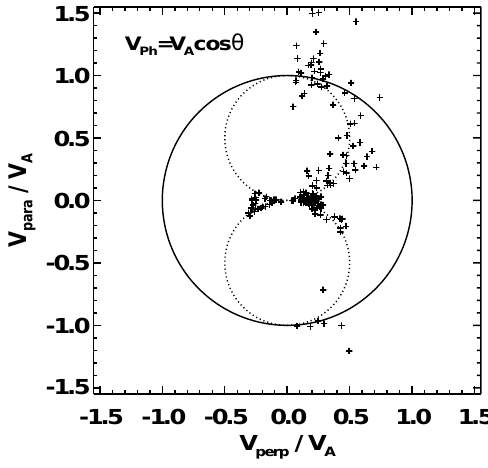
Fig. 12. Friedrichs diagram of Alfv´en-like wave events featuring phase velocities comparable to V A × cos θ (dotted line).